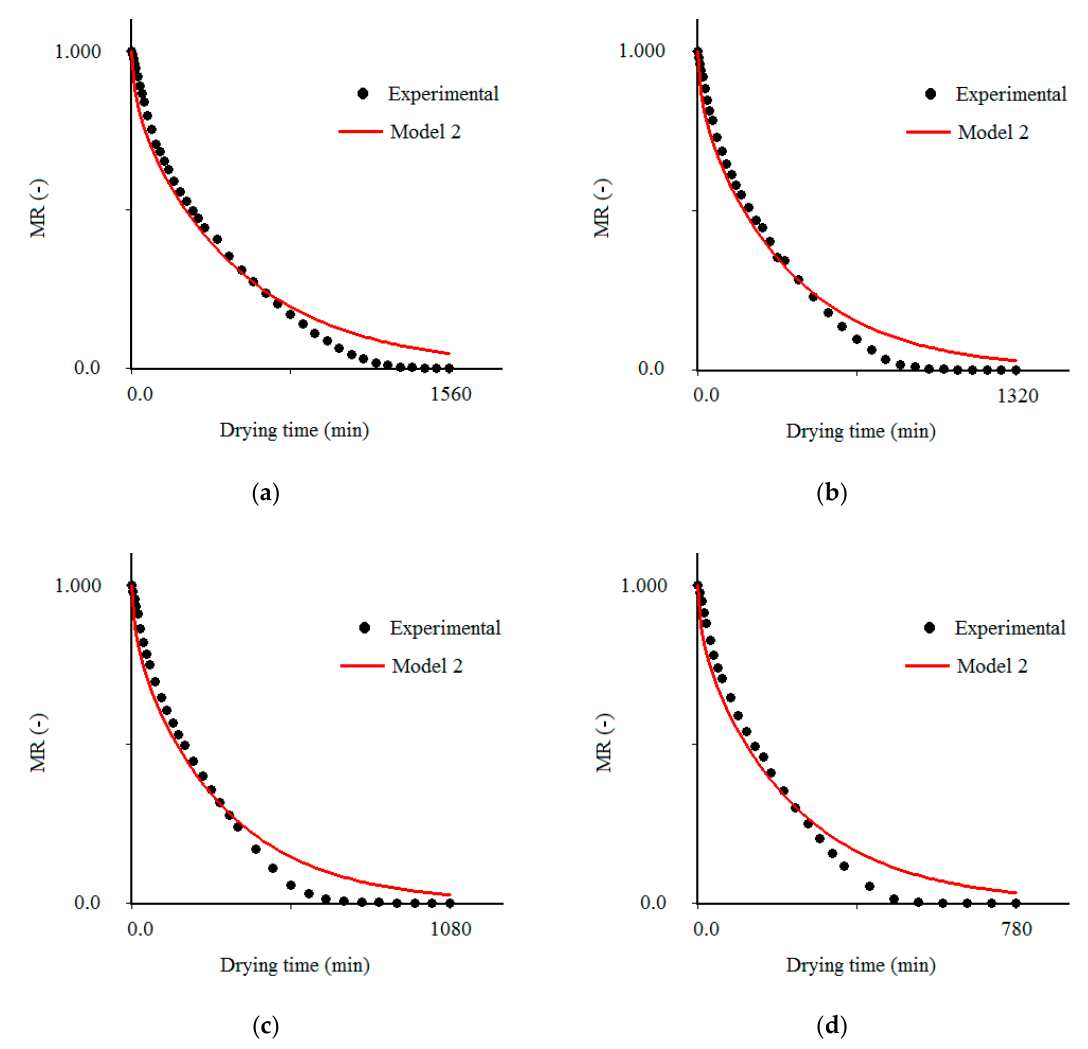
Figure 2. Comparison of dimensionless moisture contents obtained in the experiment and predicted using model 2 at drying air temperatures of ( a ) 50 °C, ( b ) 60 °C, ( c ) 70 °C and ( d ) 80 °C.